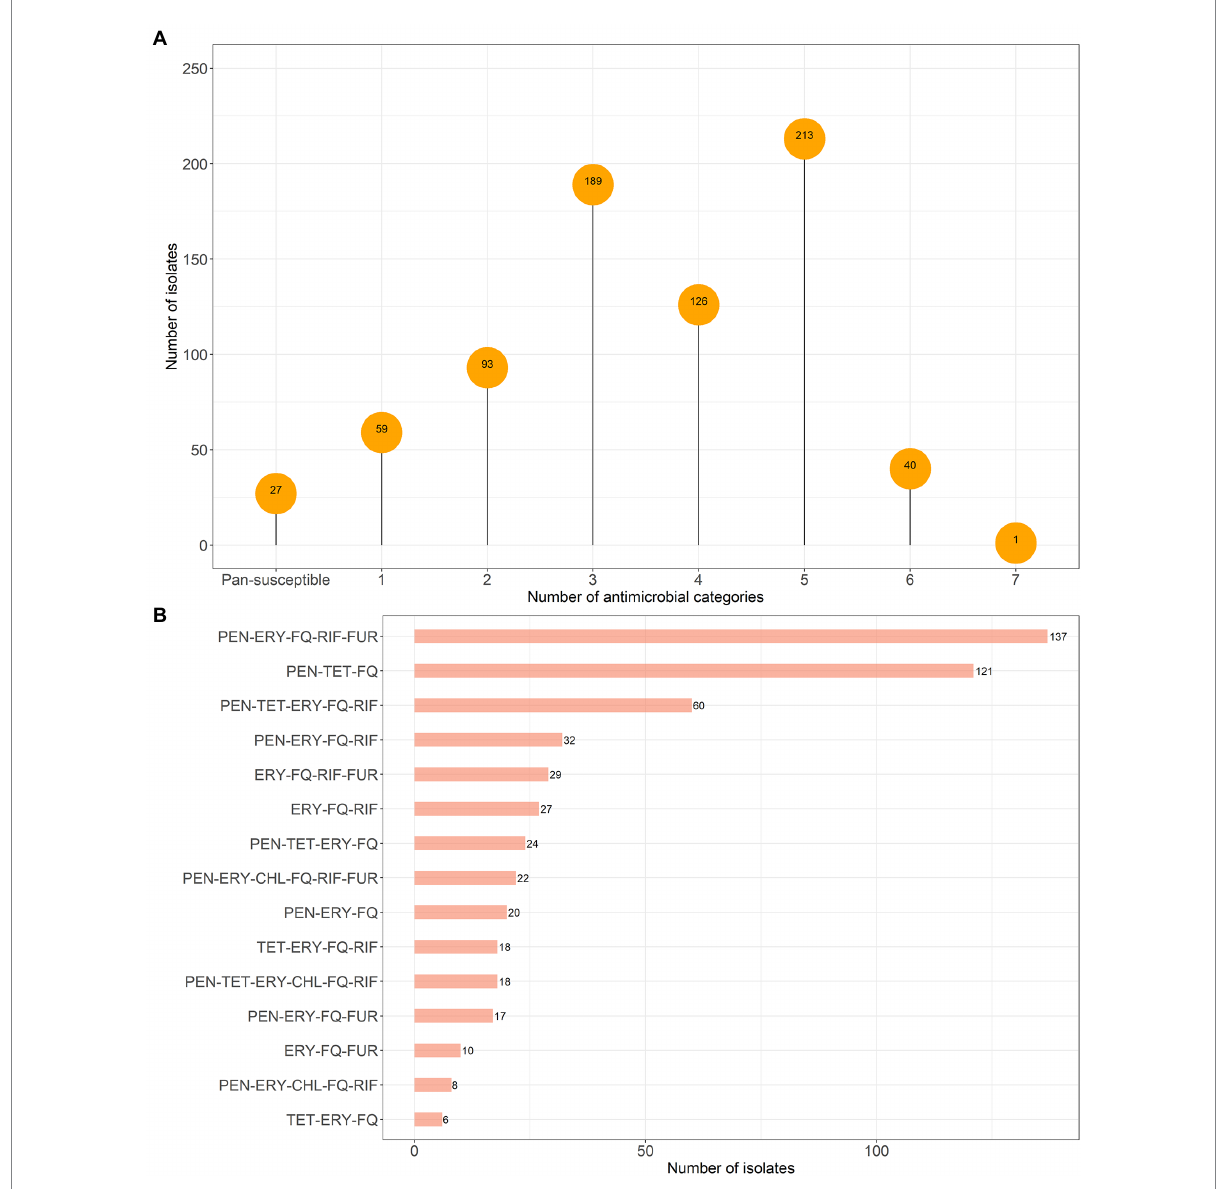
FIGURE 2 Distribution of resistance by number of antimicrobial categories (A) and most 15 common multidrug resistance patterns among Enterococcus faecium isolates (B) , in canine clinical infections at the Cornell University Animal Health Diagnostic Center (AHDC), 2007–2020. Antimicrobial category abbreviations are listed in Table